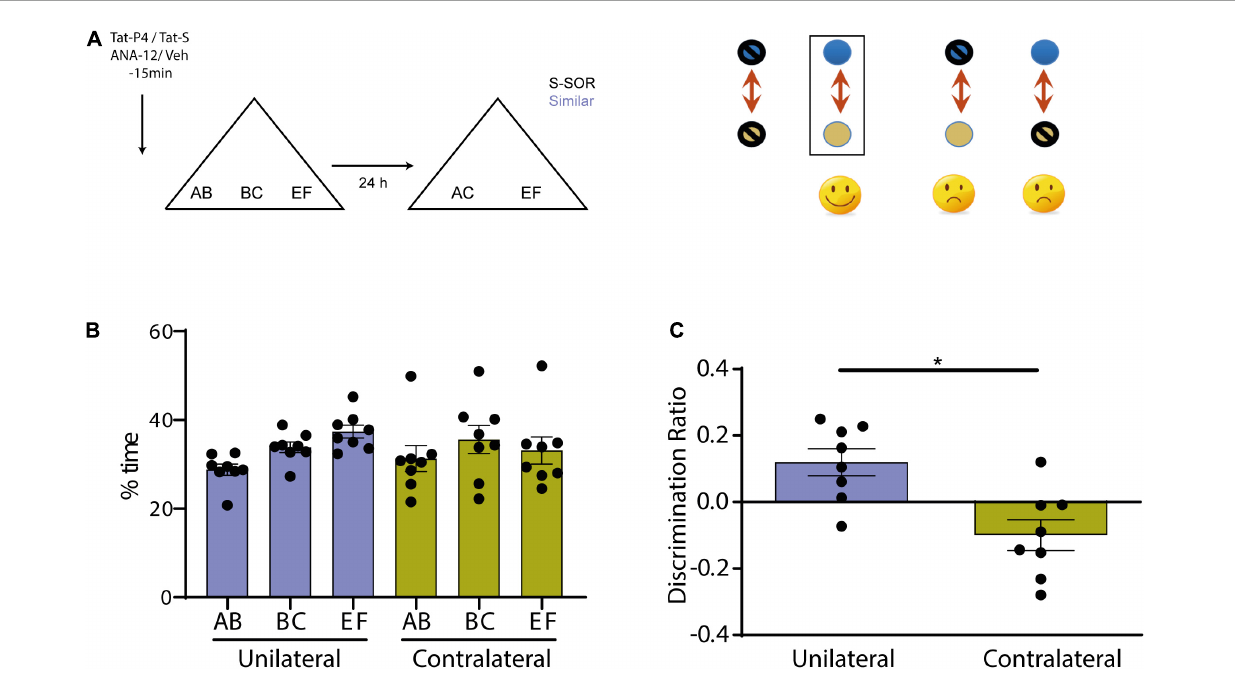
FIGURE5 (A) Schematic illustration of the similar-spontaneous object recognition task (s-SOR) task indicating when ANA-12/TatS and Veh/TatP4 was infused (left). In a molecular disconnection experiment, there is an inactivation of two elements of a signal transduction pathway either in the same hemisphere or in both of them. While in the first case, the putative pathway that links both proteins remain intact and functional in one hemisphere, the inactivation of one element in one hemisphere and the other element in the other hemisphere prevents functionality of the putative interaction pathway in both hemispheres (right). (B) Percentage of time spent exploring each of the objects in the sample phase. Repeated-measures two-way ANOVA (%time), s-SOR: pcondition = 0.7318, pobject = 0.1943, pinteraction = 0.4355. (C) We found no effect in the similar SOR task when ANA-12 and TatP4 were injected in the same hemisphere [One-sample t -test (same, t = 2.964), p = 0.0210]. However, when ANA-12/TatS and Veh/TatP4 where injected in different hemispheres in Prh, we found a significant impairment in the similar SOR task [One-sample t -test (different, t = 2.150), p = 0.0686; paired t -test same vs. different, p = 0.0090, t = 3.574, n = 8]. * p <